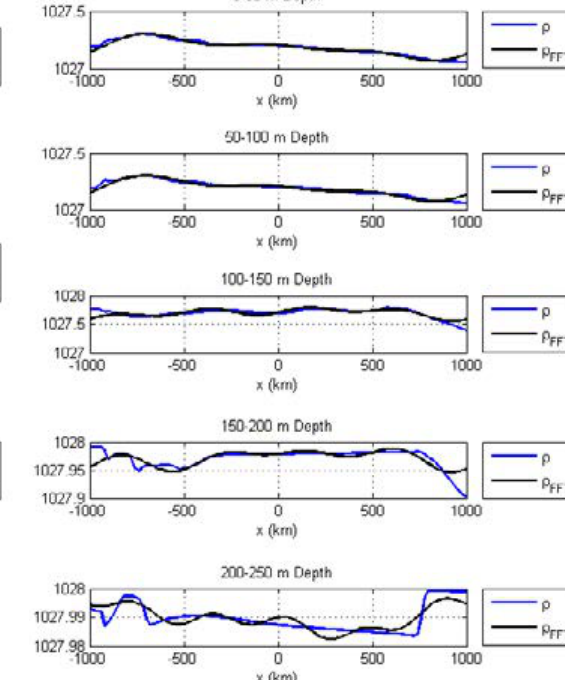
Fig. 8 : The density plot of each layer depth from the FFT results